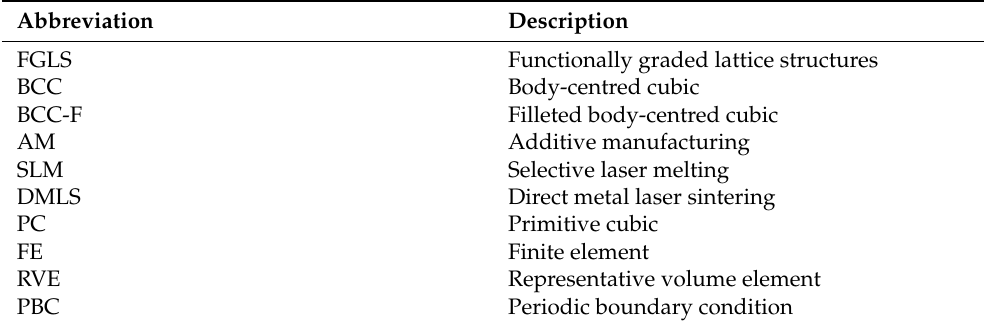
Table 1. Abbreviations used in the